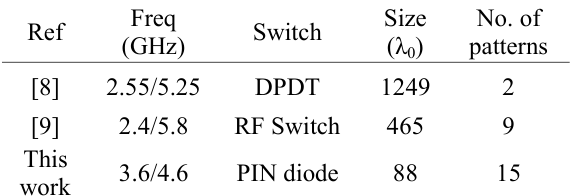
Figure 10: Measured and simulated radiation patterns in elevation plane. Table 3: Comparison of the proposed antenna with the reported dual-band pattern diversity antennas.